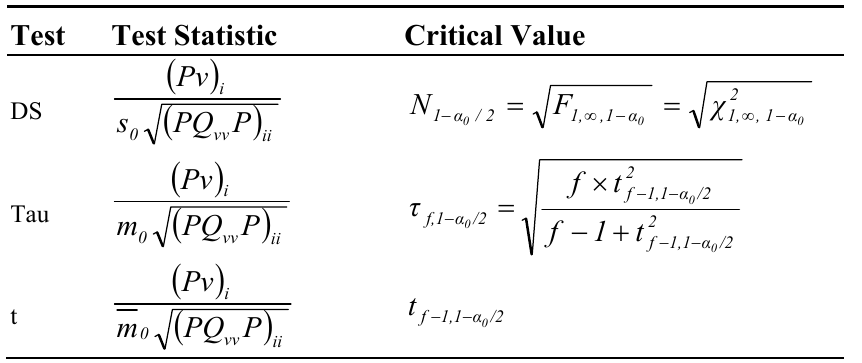
Table 1. Test statistic and critical values